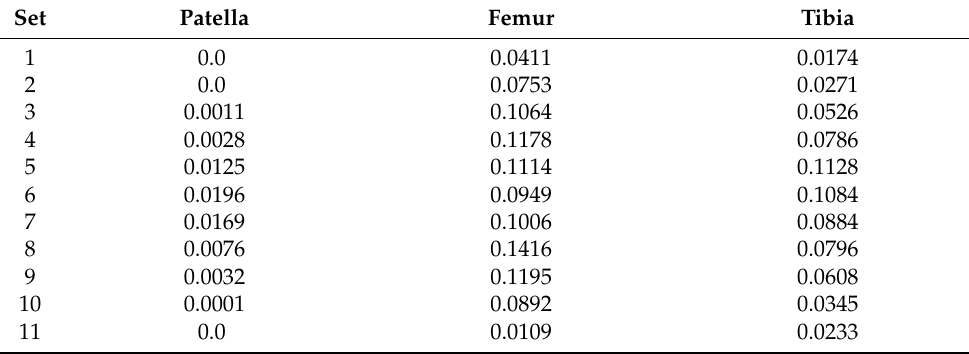
Table 4. Normalized area values due to the size of the knee on the sagittal plane.